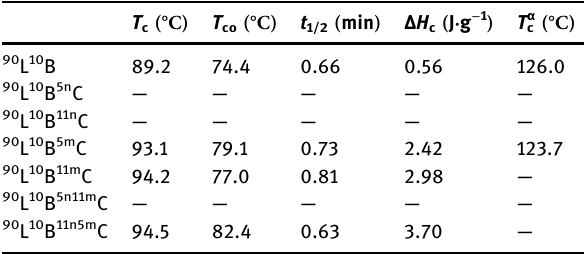
Table 4: Parameters derived from the cooling DSC